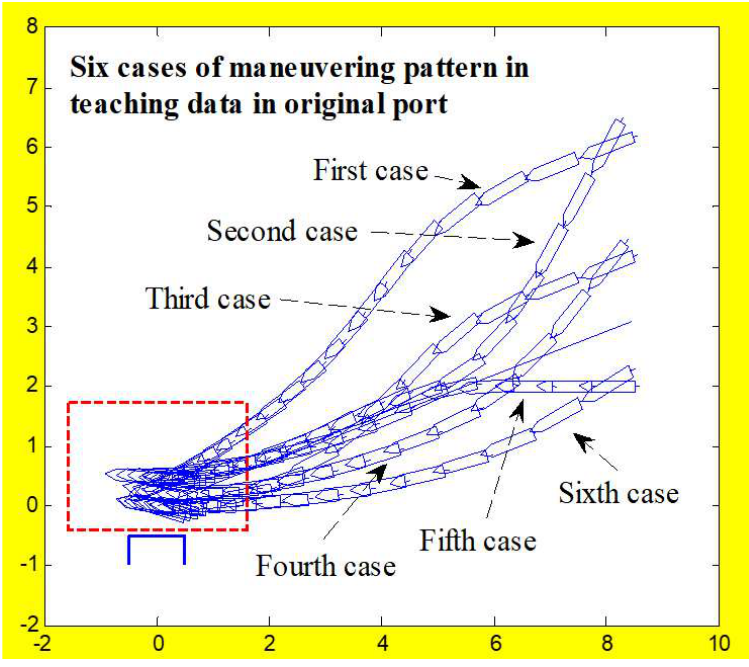
Figure 8. Teaching data generation with six samples of ship maneuvering.